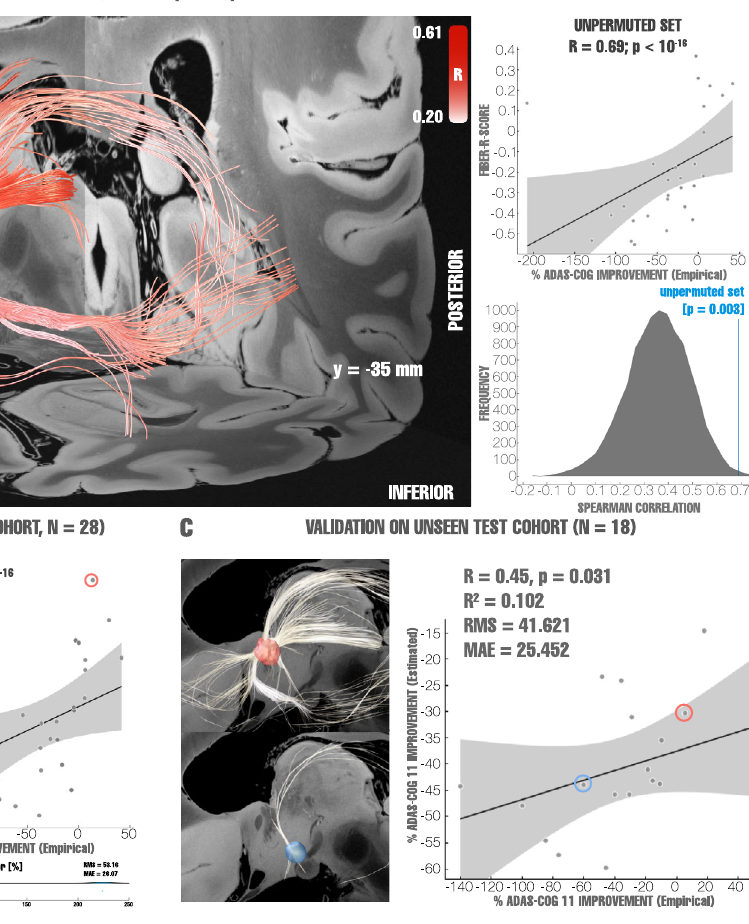
Fig. 2 | Validation of tract models predictive of clinical improvements as evaluated using ADAS-cog 11. a Left: Optimal set of tracts to be modulated as calculatedfromtheentiretrainingcohort( N =28subjects),redintensitycodesfor R-values ranging from 0.2 to 0.6, with darker colors indicating higher R-values. Right: permutation analysis calculated on the entire training cohort ( R =0.69 at p =0.003). b Top left: stimulation volume of a patient with top clinical improve- ment overlapping the tracts associated with optimal clinical improvements (cal- culated leaving out the subject, N =28-1=27 subjects). Fibers displayed in white correspond to the portion of optimal fi bers intersecting with the patient ’ s stimu- lation volume. Bottom left: Same analysis carried out with a poor-responding example patient. Right: Cross-validation within thetraining cohort( N =28)using a leave-one-outdesign(top, R =0.69at p <10 − 16 ),Spearmancorrelationbetweenthe degree of stimulation of positive fi bertracts (aggregated R-scores under each E- fi eld) and clinical improvements, and within-fold analysis, reporting root mean square error (RMS) and median absolute error (MAE). The boxplot displays the